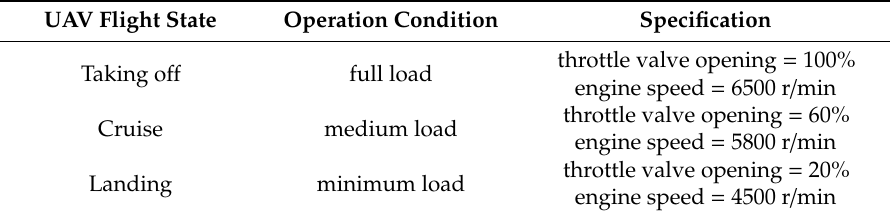
Table 12. Three typical operation conditions of the initial prototype